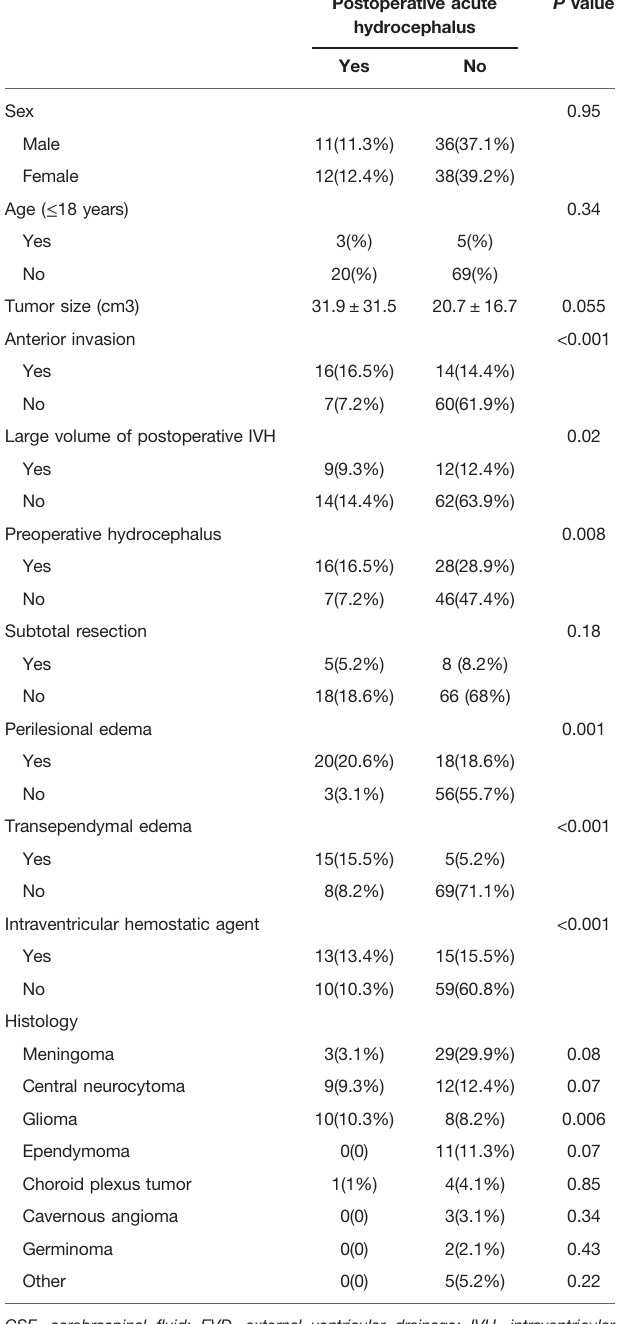
TABLE 2 | Summary of the factors with postoperative acute hydrocephalus required CSF drainage by EVD.